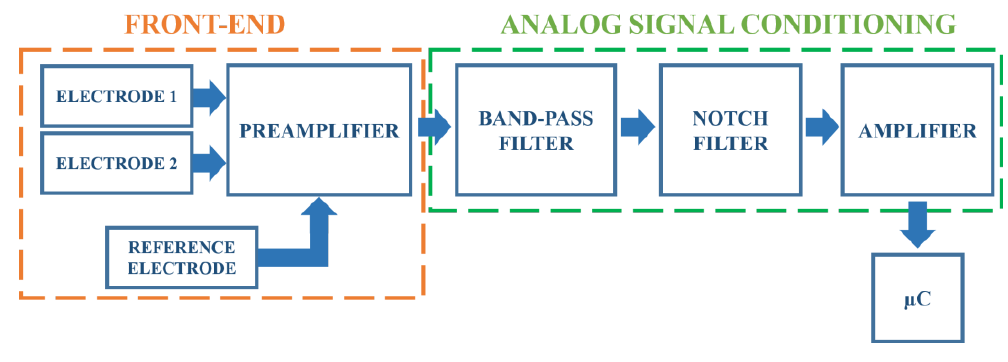
Figure 1. The proposed system block scheme.